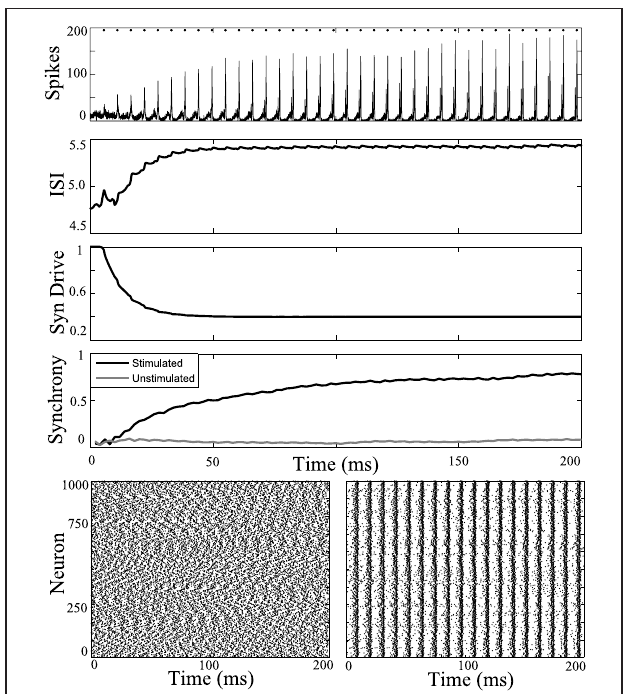
FIGURE 3 | Synchronizing a tonic phase model using periodic drive. Computational simulation of network activity with current set to 6nA to simulate tonic phase of seizure. Top , population is entrained to periodic stimuli (points of stimulation as dots along top axis). ISI increases from 4.8 to 5.5ms. Synaptic drive decreases from depression due to strong input from DBS. Synchrony of unstimulated network is low (gray) and stimulating with 5.5ms pulses increases synchrony. Below , rasterplots of neuronal network spike times during unstimulated tonic activity and with network stimulation to synchronize. Spike times of 1000 model neurons from the 3000 cell network simulation. Left , unstimulated cells have low synchrony. Right , network stimulated with 5.5ms pulses becomes